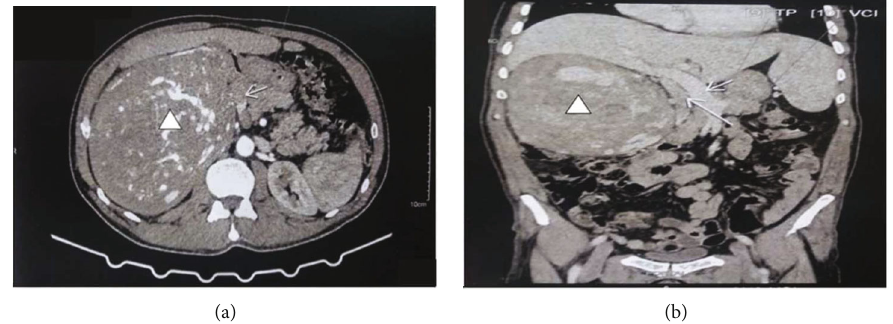
Figure 1: Abdominal computerized tomography scan showing (a) a heterogeneous mass occupying the right kidney (arrowhead). (b) The mass seems to arise from the renal parenchyma (arrowhead) and to extend into the renal vein lumen while compressing the inferior vena cava (arrow).